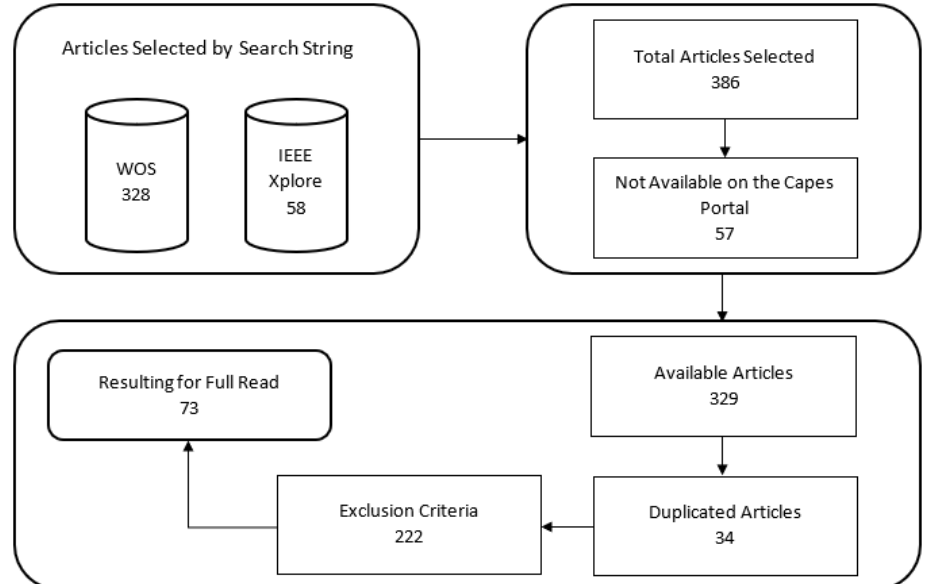
Figure 1. Articles filtering during the conducting